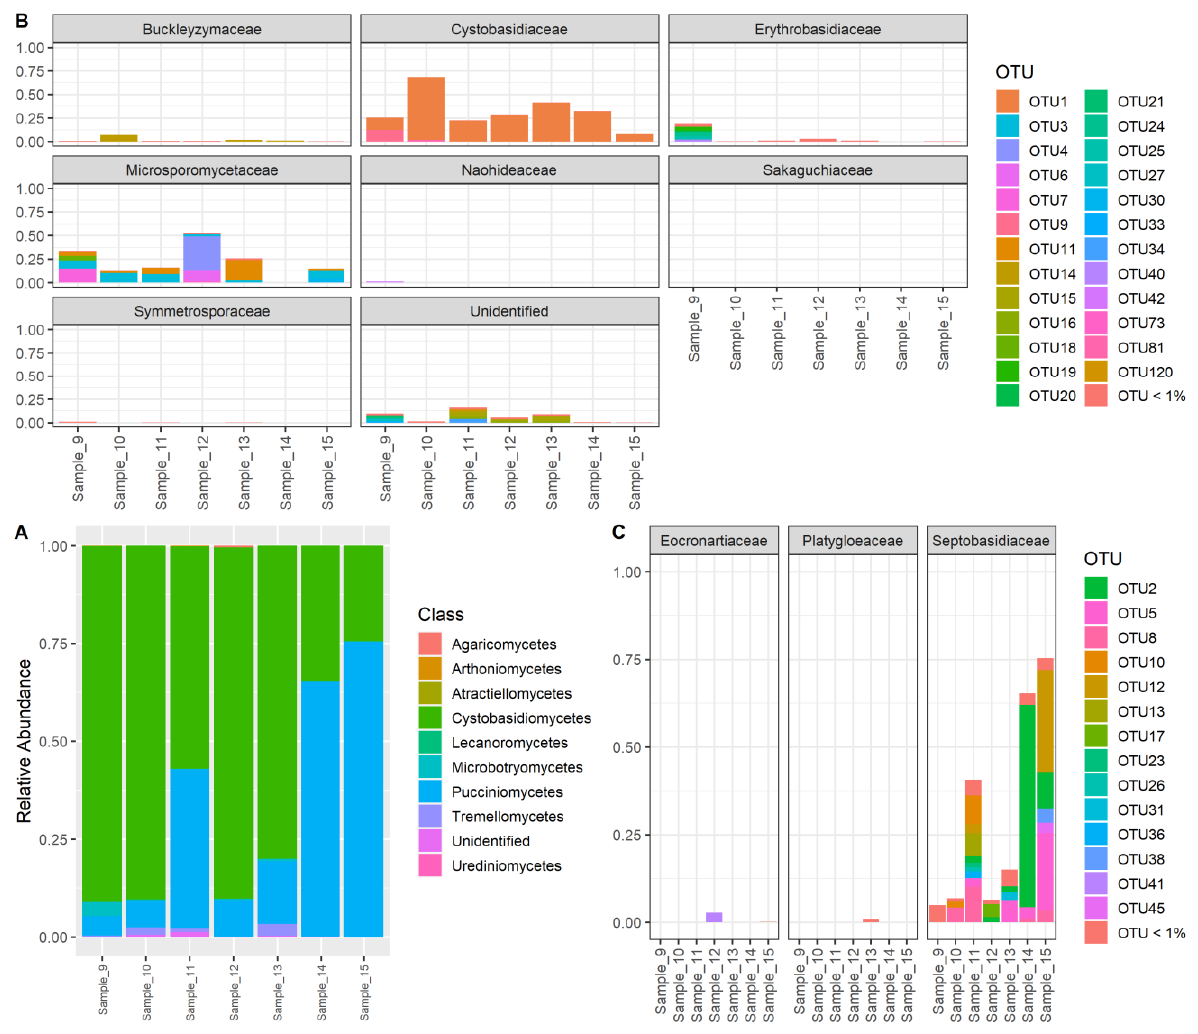
Figure 3. The Proportion of OTUs in meta-barcoding reads. ( A ) Relative abundance at the class level; ( B ) OTU level corresponding to each family within the Cystobasidiomycetes class; ( C ) OTU level corresponding to each family within the Pucciniomycetes class. The OTUs with low abundance (<1%) were grouped together.